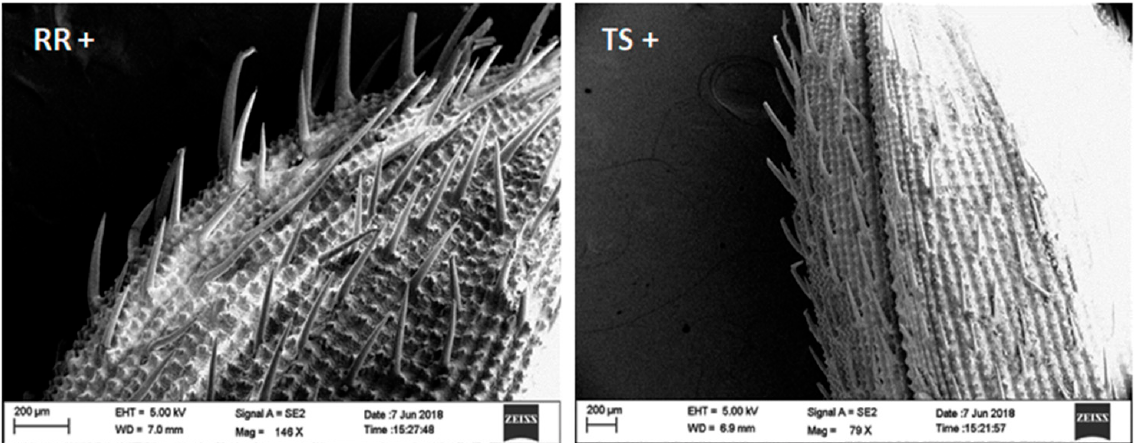
Figure 5. SEM micrographs for rice grains depicting different spike-like hair orientations for Dharam rice (DRS+, susceptible), Black rice (BR+, resistant), Ranjit Rice (RR+, resistant), and Thangjing rice (TS+, susceptible).